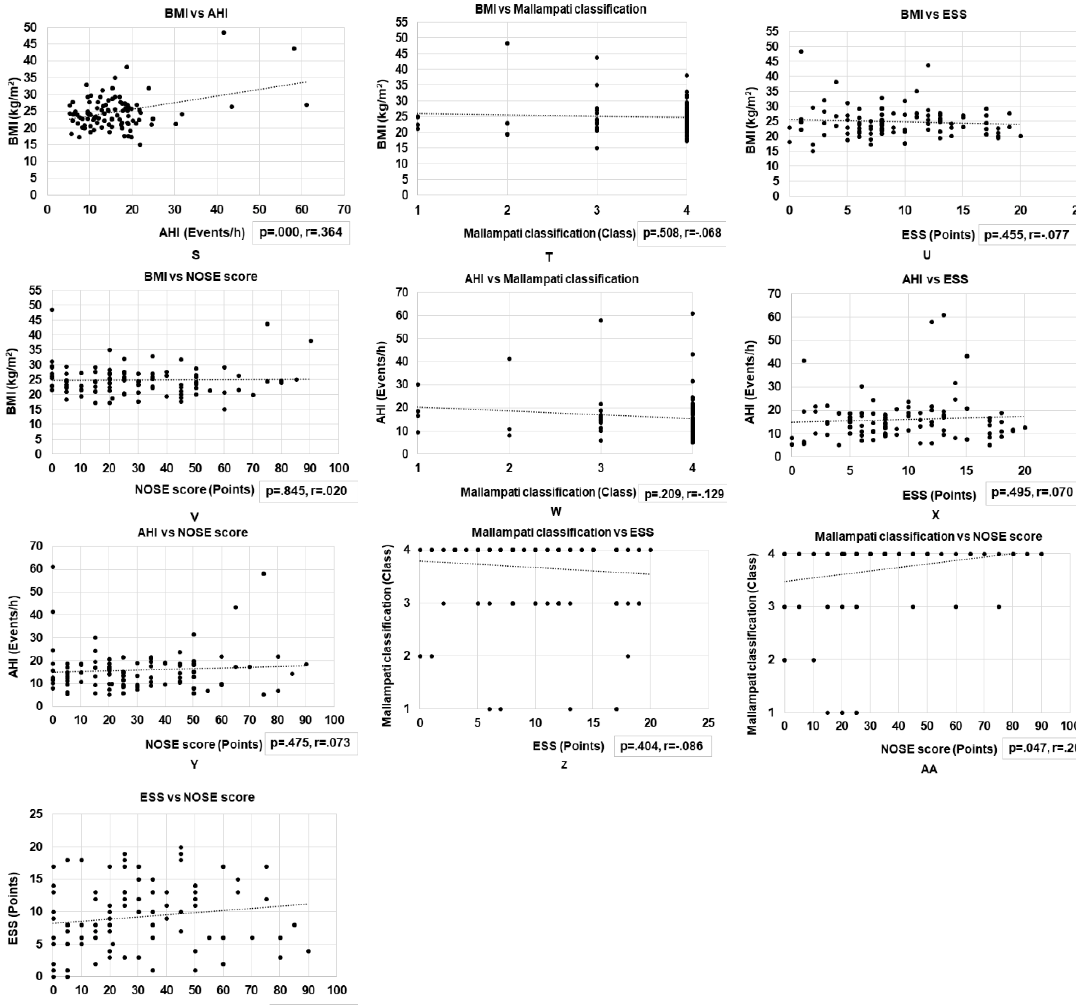
Figure 1. Correlations between basic clinical variables and nasal obstruction assessments in patients with obstructive sleep apnea. ( A – G ) Correlations between PNIF and AHI, SpO 2 min, age, BMI, Mallampati classification, ESS, and NOSE scores. ( H – M ) Correlations between SpO 2 min and AHI, age, BMI, Mallampati classification, ESS, and NOSE scores. ( N – R ) Correlations between age and AHI, BMI, Mallampati classification, ESS, and NOSE scores. ( S – V ) Correlations between BMI and AHI, Mallampati classification, ESS, and NOSE scores. ( W – Y ) Correlations between AHI and Mallampati classification, ESS, and NOSE scores. ( Z – AA ) Correlations between Mallampati classification and ESS and NOSE scores. ( BB ) The correlation between ESS vs. NOSE. AHI, apnea–hypopnea index; BMI, body mass index; ESS, Epworth Sleepiness Scale; NOSE, Nasal Obstruction Symptom Evaluation; PNIF, peak nasal inspiratory flow; SpO 2 min, minimum oxygen saturation.